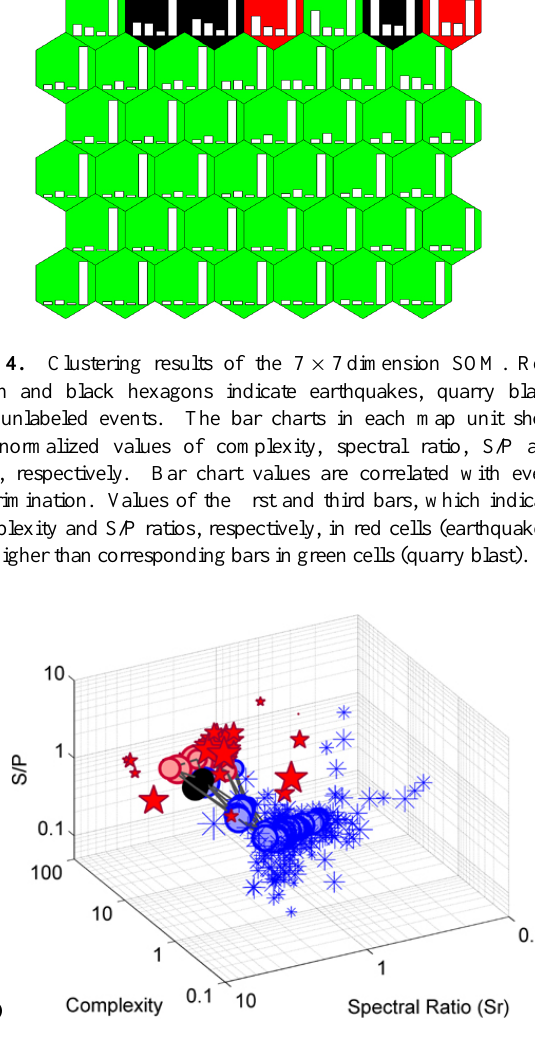
coordinates represent the first three variables and the size of the marker shows the size of the fourth variable, time. Red stars indicate EQs and blue stars indicate QBs. Circles represent the map units (neurons) of the SOM. Nodes are classified into two classes after training. Black